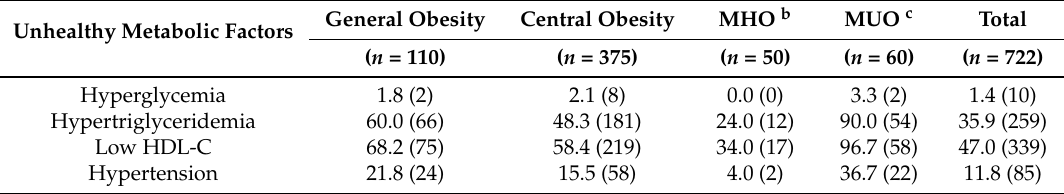
Table 2. Percentage of unhealthy metabolic factors in obese adolescents in the Tehran Lipid and Glucose Study a